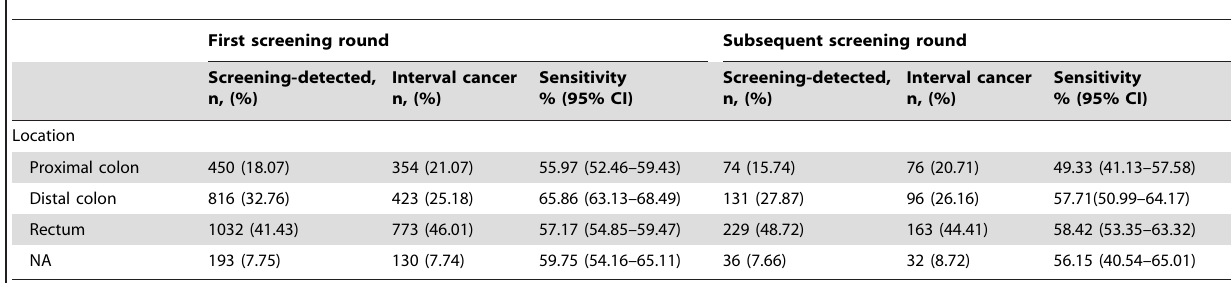
Table 4. Validity of FOBT for colorectal cancer by anatomical